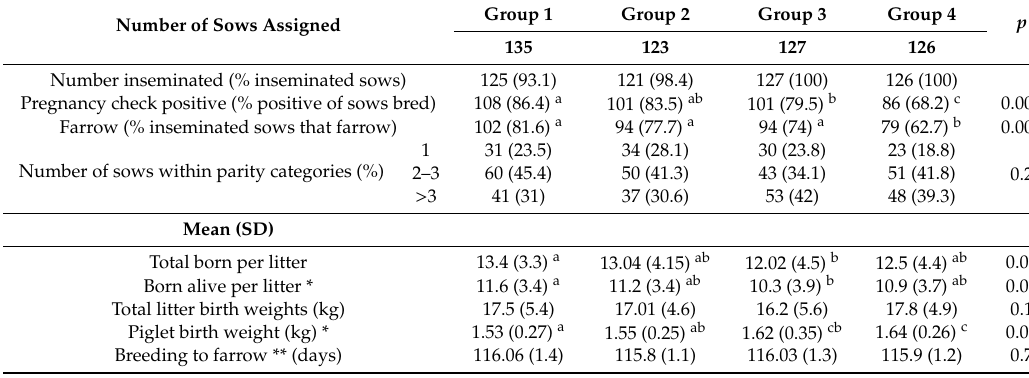
Table 1. Reproduction performance of sows assigned to one of four